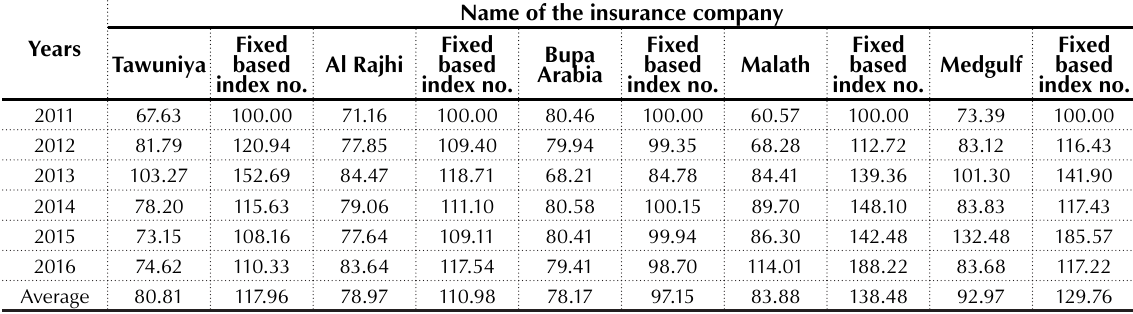
Table 1. Loss ratio (ratios are in percentage) Years